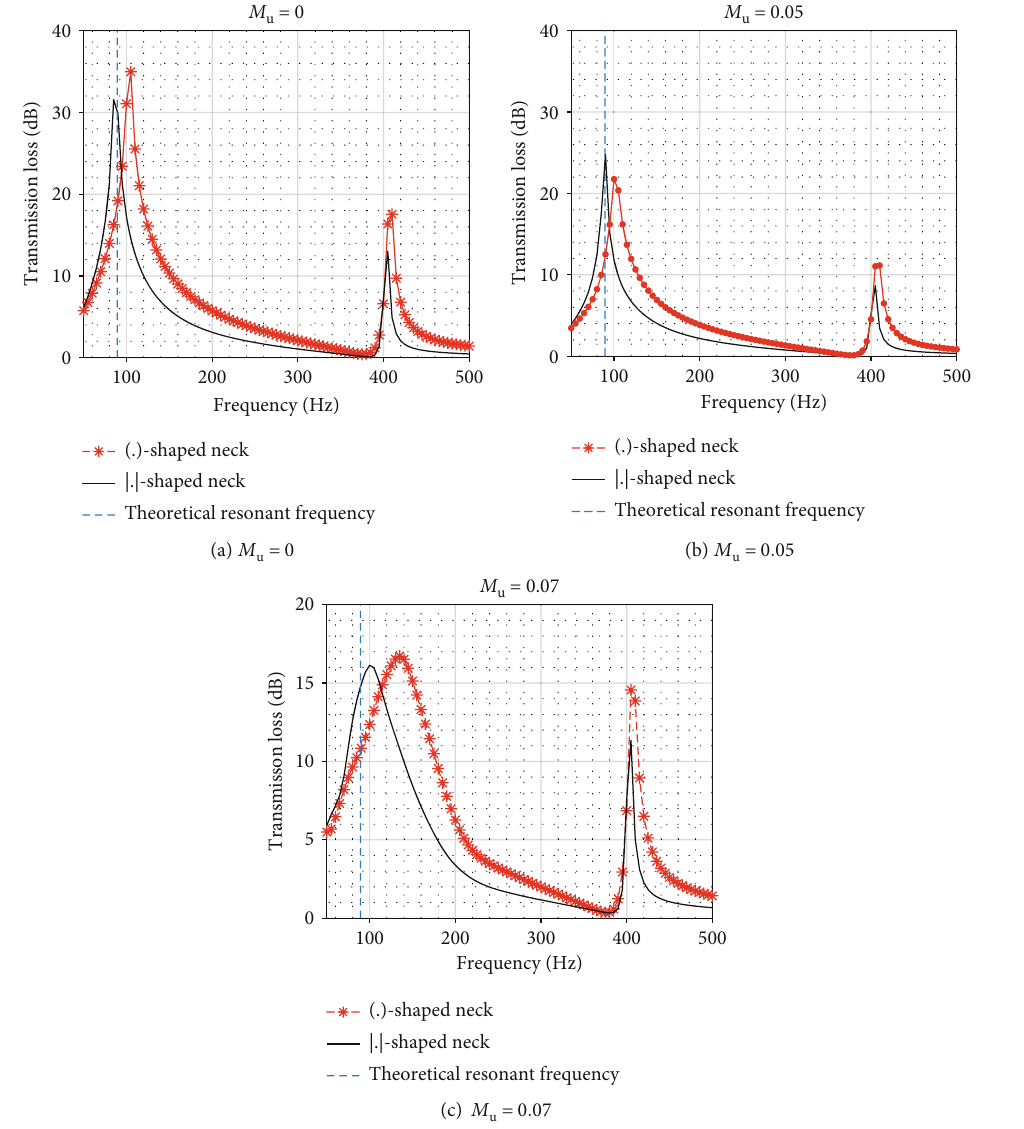
Figure 10: Comparison of the transmission loss performances, as the resonator neck shape is changed from the conventional j ⋅ j to arc ð ⋅ Þ con fi guration. Here, the rigid ba ffl e dimensions are set to be L